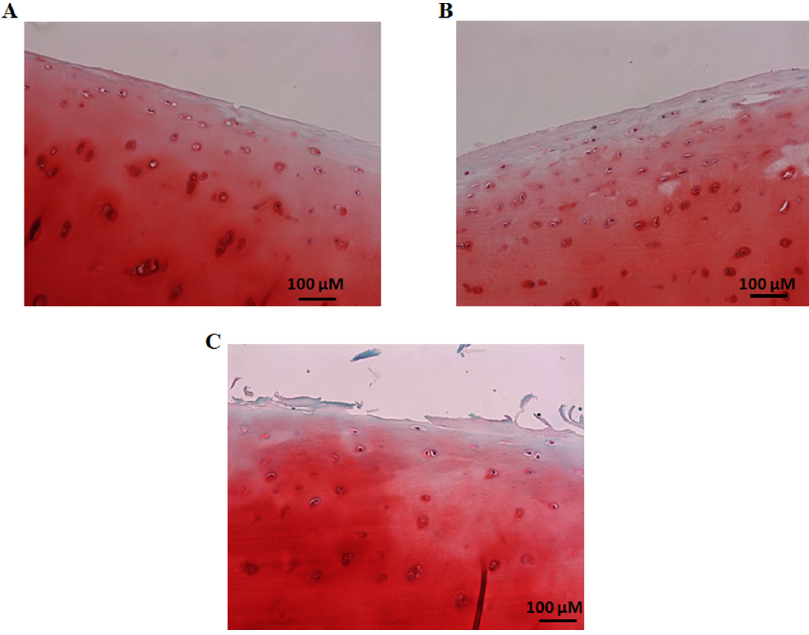
Figure 3. Representative histologic staining with Safranin O fast green. (A) Normal human articular cartilage section shows uniform Safranin O staining intensity till articular surface. (B) Slight reduction in Safranin O staining intensity at the articular surfaces is observed in a cartilage sample with early OA stage (C) reduced Safranin O staining is observed at the articular surface of a cartilage sample with advanced OA stage due to rupture of cartilage. Magnification x20; scale bars 100 m